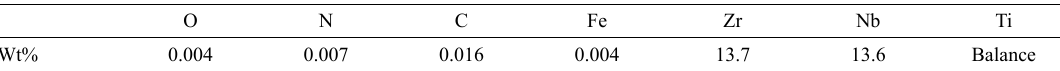
Table 1. The chemical analysis (in wt%) of the fabricated